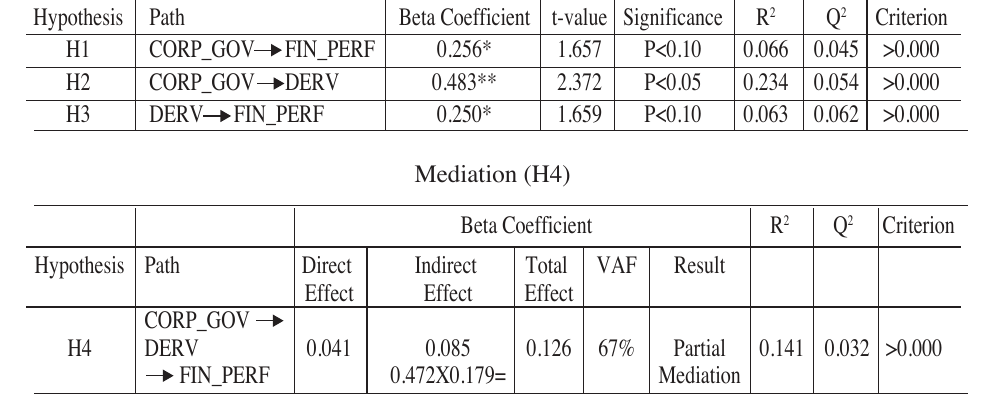
Table 18: Conditions of Mediation (H1 to H3) -2010